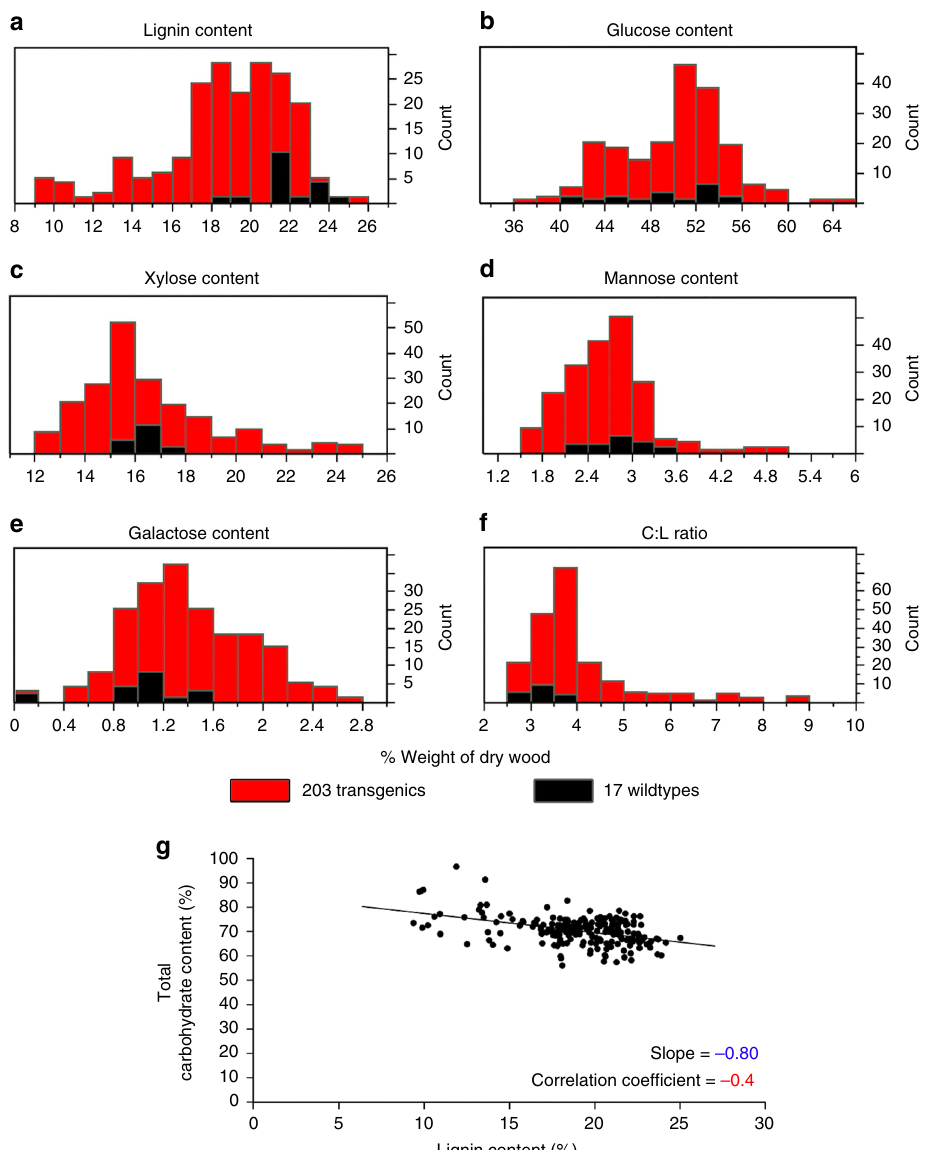
Fig. 5 Variation of lignin and carbohydrate contents in transgenic and wildtype P. trichocarpa . a lignin, b glucose, c xylose, d mannose, and e galactose contents, and the carbohydrate to lignin (C:L) ratio f in the wood of transgenic (red bars) and wildtype (black bars) P. trichocarpa . See Supplementary Data 3. g Lignin and total carbohydrate contents are negatively correlated. The negative linear relationship has a slope of − 0.8 and a correlation coef fi cient of − 0.4. Each data point represents a replicate pool of one wildtype or transgenic line containing 3 – 5 clonally propagated